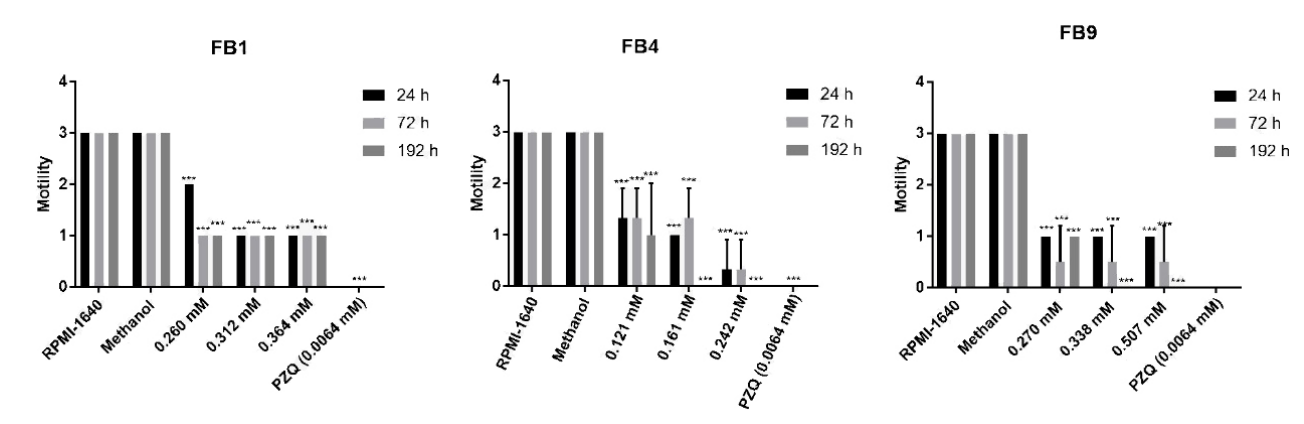
Figure 2. Motility of adult Schistosoma mansoni worms after exposure to different concentrations (0.260 to 0.364 mM for FB1; 0.121 to 0.242 mM for FB4 and 0.270 to 0.507 mM for FB9) of the eugenol derivatives for 24, 72 and 192 hours of incubation. RPMI-1640 and methanol were used as control and praziquantel (PZQ) as pharmacological control. ***Statistic analyses with significant result (p < 0.05) in relation to control groups.